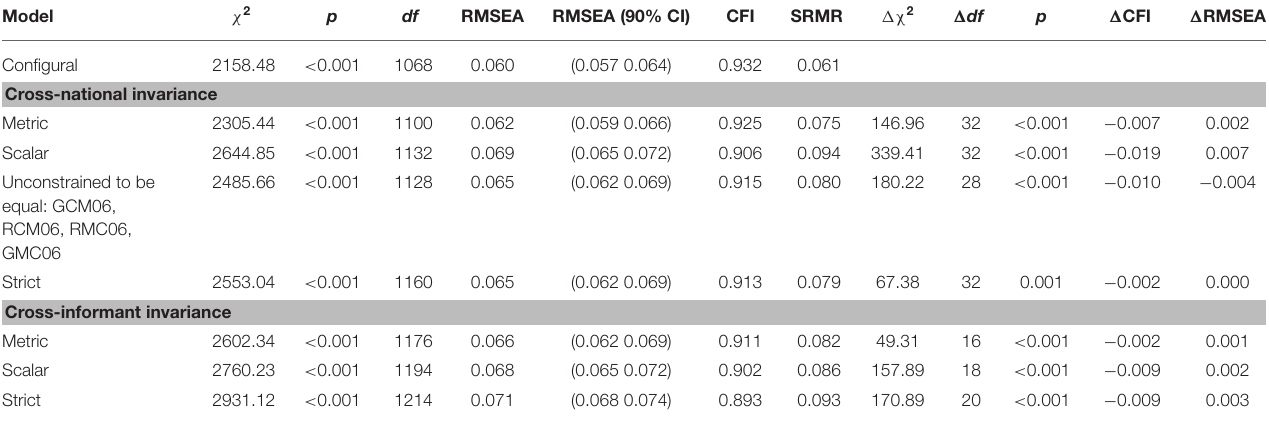
TABLE 7 | Cross-national and cross-informant invariance of the accuracy model for the mother–child relationship. Model